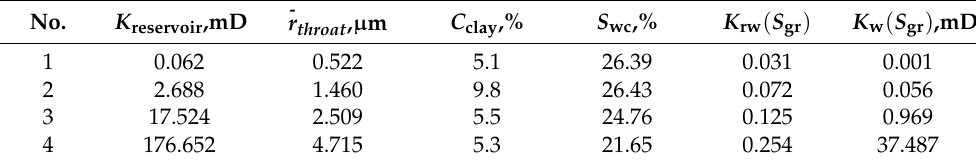
Figure 4. Water phase relative and effective permeability curve. Table 3. Water phase characteristic value and rock sample property parameter.